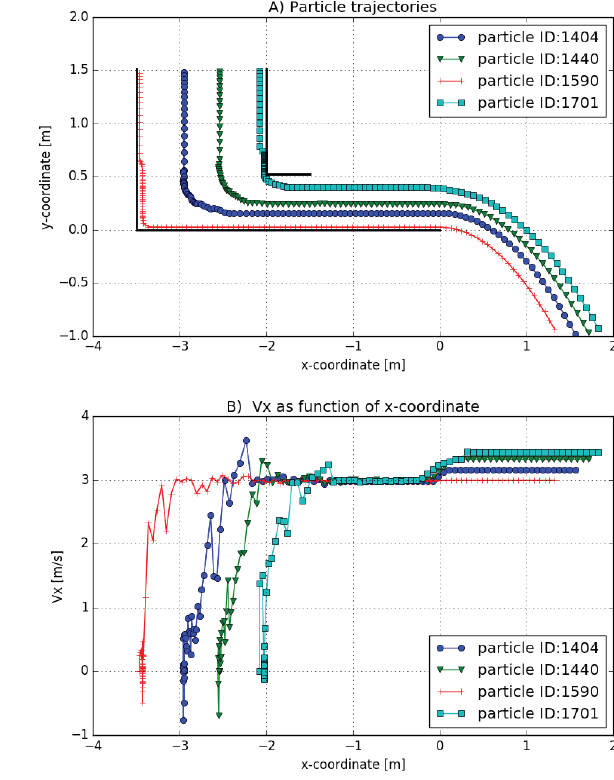
Figure 4. Influence of layer height on V x increase. Tracking position and V x of 4 particles in di ff erent layer heights, we can see the higher layers give a higher and earlier increase of V x